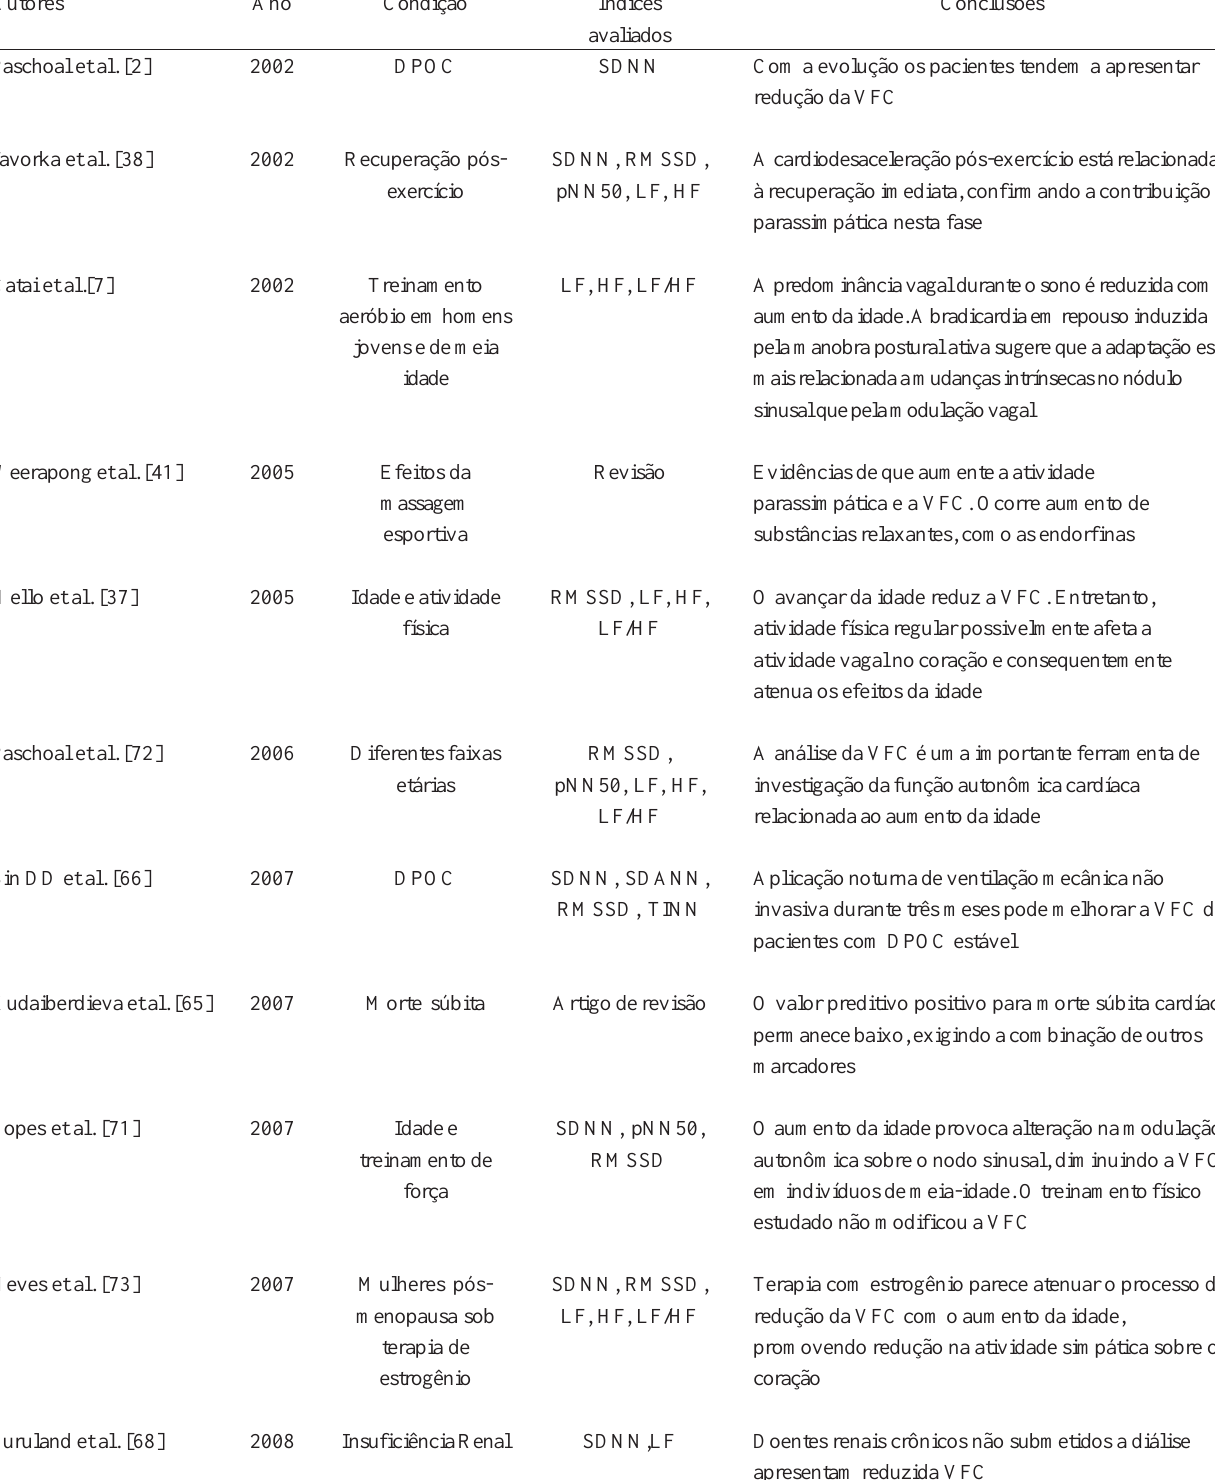
DPOC: doença pulmonar obstrutiva crônica; VFC: variabilidade da frequência